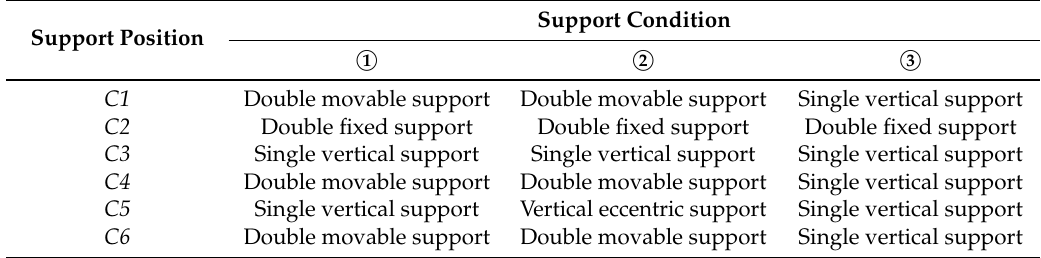
Table 5. Support conditions of an irregularly-shaped bridge.